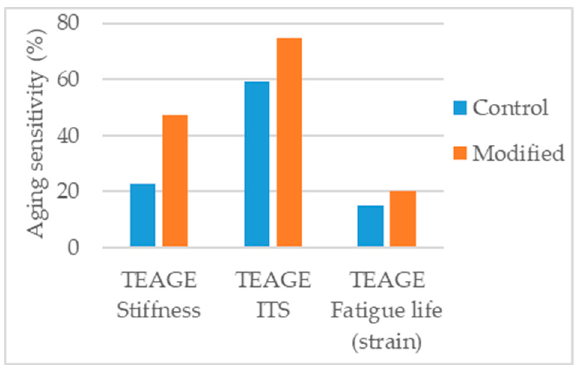
Figure 21. Aging sensitivity of the parameters considered in the study [131].